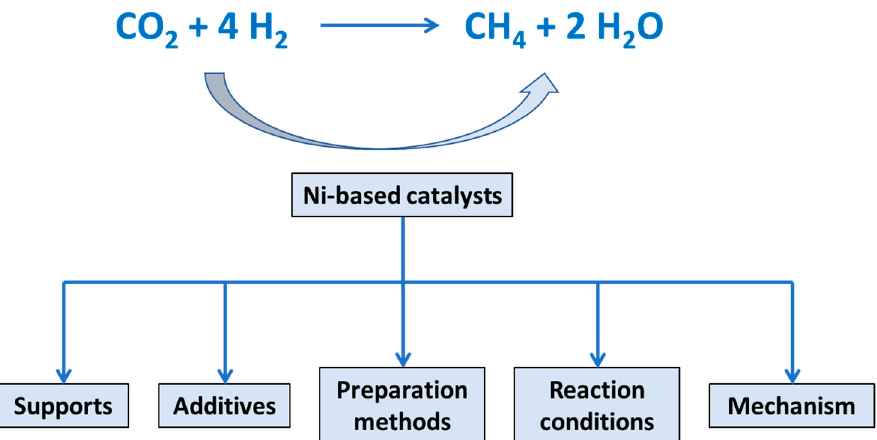
Figure 6. Main parameters influencing the catalyst design to improve the catalytic performance of supported Ni catalysts in the CO 2 methanation process. Adapted from ref. [54].